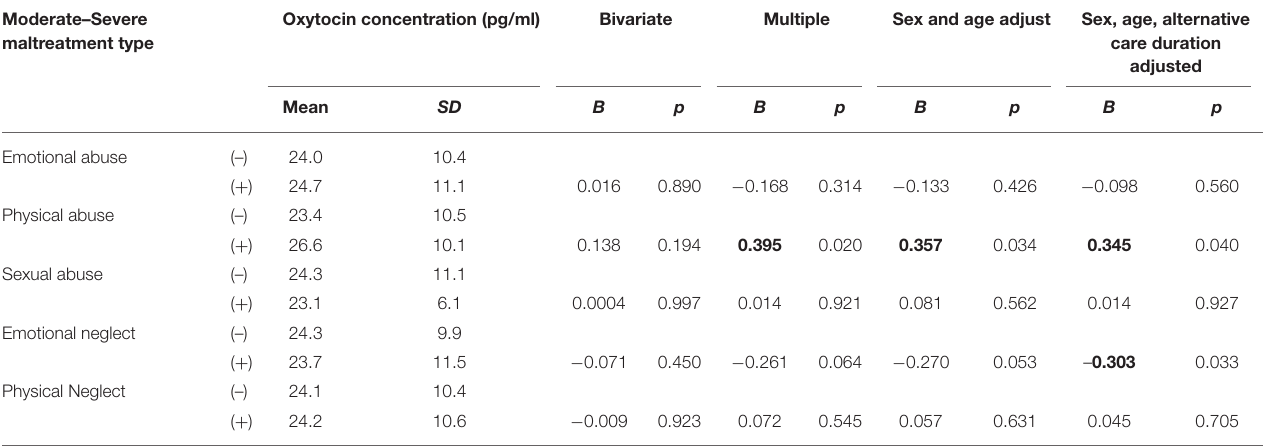
TABLE 3 | Regression coefficients of moderate–severe maltreatment types on